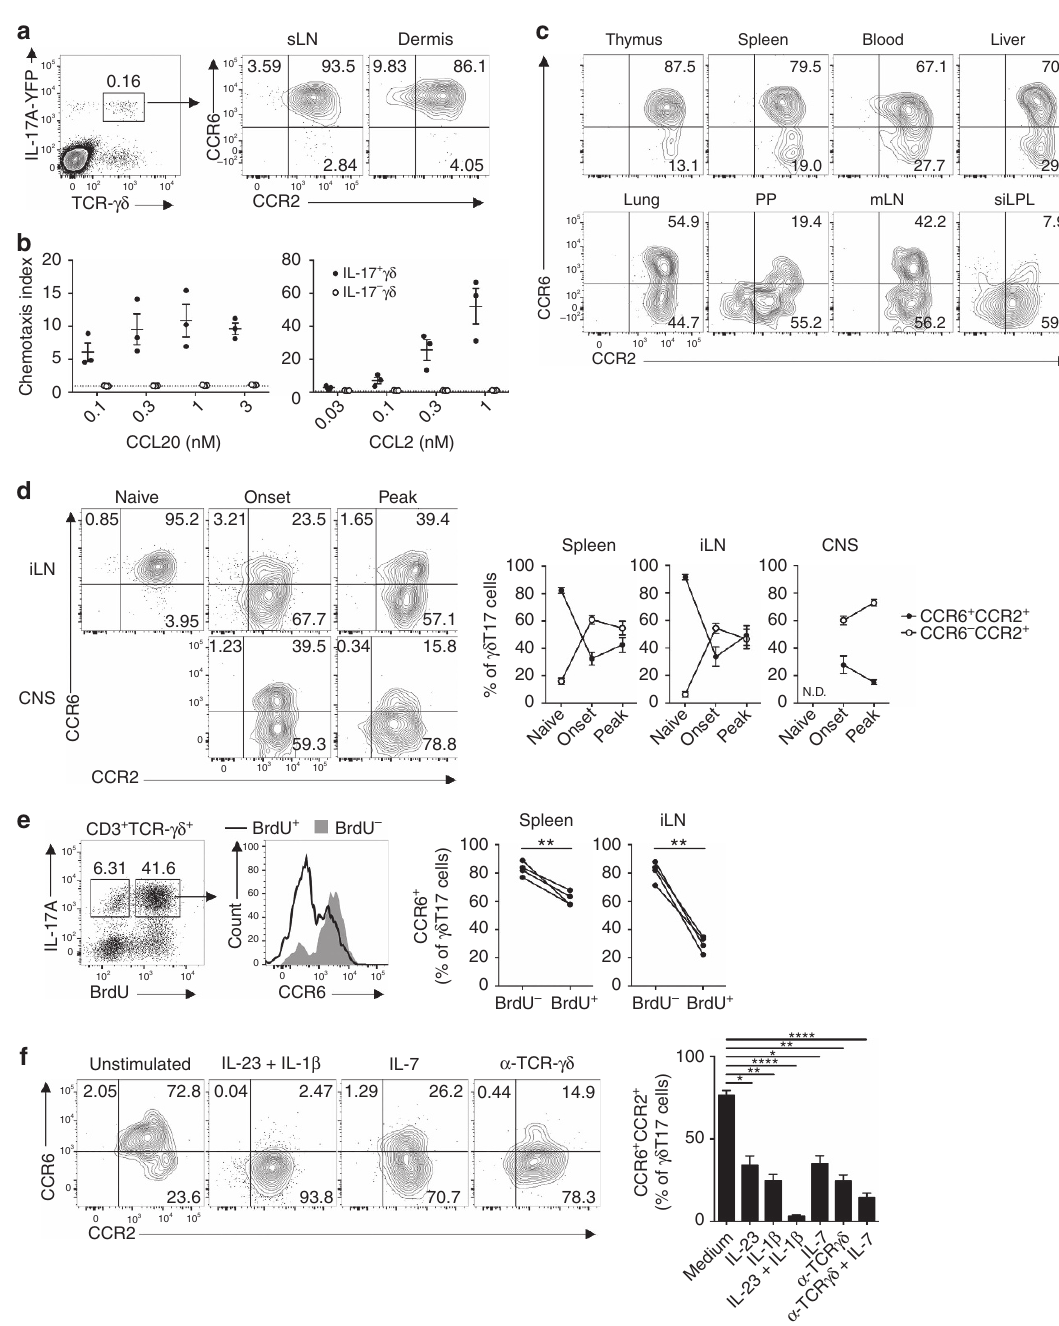
Figure 1 | cd T17 cells downregulate CCR6 upon activation. ( a ) Representative flow cytometry of CCR6 and CCR2 expression in skin-draining lymph nodes (sLN) and dermal CD3 þ TCR- gd þ IL-17A-YFP þ gd T17 cells from Il17a Cre (cid:3) Rosa26 eYFP mice ( n ¼ 3). ( b ) Ex vivo transwell chemotaxis of Il17a Cre (cid:3) Rosa26 eYFP splenic IL-17A þ / (cid:2) gd T cells to CCL20 and CCL2 ( n ¼ 3). ( c ) Representative flow cytometry of CD45 þ gd T17 cells from organs of naı¨ve Il17a Cre (cid:3) Rosa26 eYFP mice ( n ¼ 3). mLN, mesenteric lymph node; PP, Peyer’s patches; siLPL, small intestinal lamina propria lymphocytes. ( d ) Representative flow cytometry and quantitation of CCR6 and CCR2 expression by gd T17 cells from organs of Il17a Cre (cid:3) Rosa26 eYFP mice either naı¨ve ( n ¼ 6) or at experimental autoimmune encephalomyelitis (EAE) onset ( n ¼ 7) or peak ( n ¼ 5). CNS, central nervous system; iLN, inguinal lymph node; ND, not detected. ( e ) Representative flow cytometry and quantitation of CCR6 expression by gd T17 cells from wild type (WT) mice given BrdU at d3 post-immunization for EAE, and analysed at d8 ( n ¼ 4). ( f ) Representative flow cytometry and frequency of CCR6 and CCR2 expression by gd T17 cells from Il17a Cre (cid:3) Rosa26 eYFP lymphocytes cultured with indicated stimuli for 72h ( n ¼ 5). See also Supplementary Figs 1 and 2. Mean ± s.e.m. ( a – c ) Representative of two experiments. ( d , f ) Pooled from two experiments. ( e ) Paired two-tailed Student’s t -test, ( f ) one-way paired ANOVA with Dunnett’s multiple comparisons test relative to unstimulated control. * P o 0.05, ** P o 0.01, *** P o 0.001, **** P o